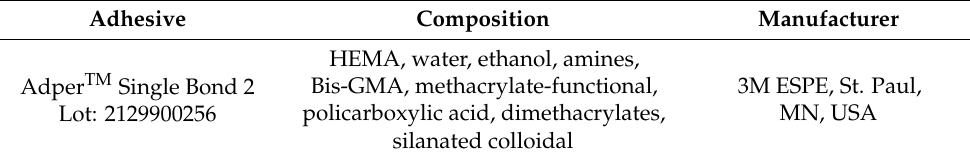
Table 1. Chemical composition of tested